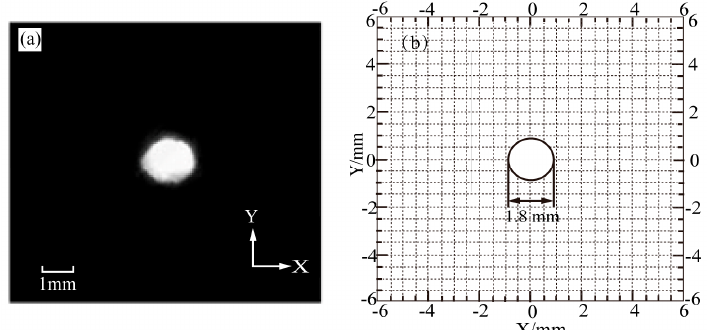
Figure 12. Comparison between experiment image and calculated result of the keyhole geometry of case a. ( a ) Experimental image. ( b ) Calculated result.